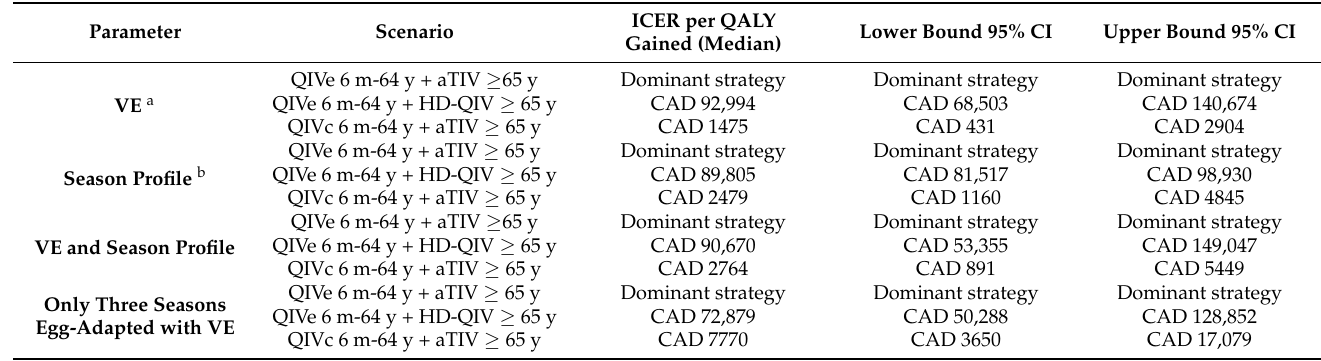
Table 5. Probabilistic sensitivity analysis of ICER based on varying vaccine effectiveness, season profile, and number of egg-adapted